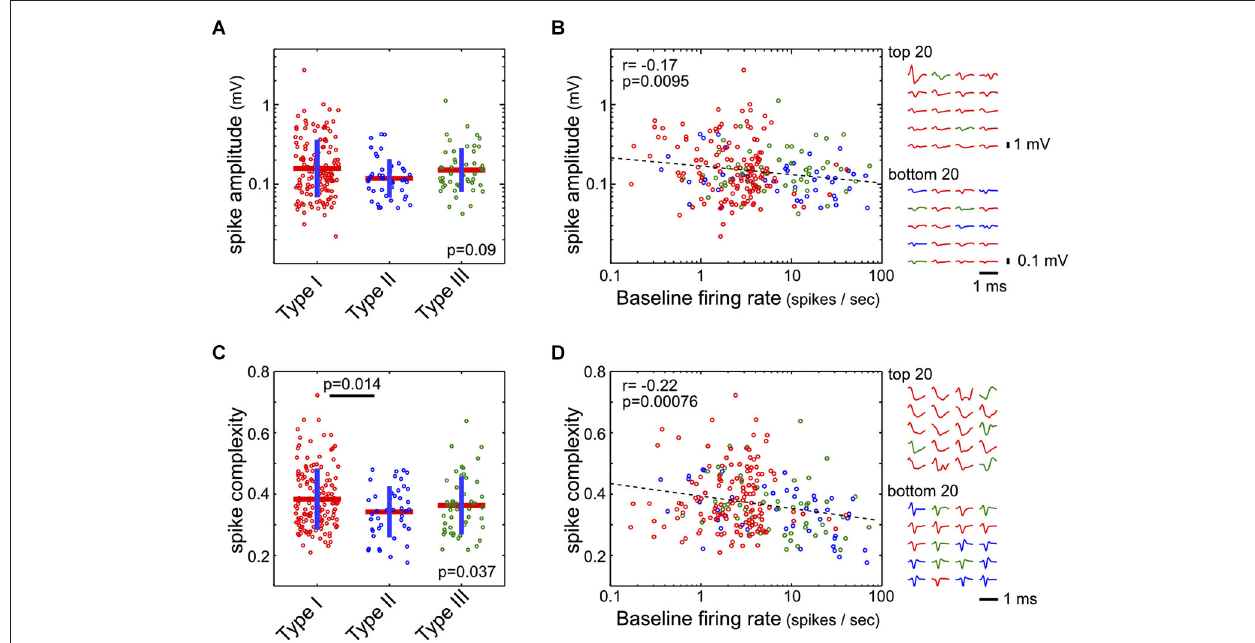
complexity, defined as the mean absolute amplitude of the peak normalized waveform, was higher in Type-I than in Type-II neurons (ANOVA, F ( 2,232 ) = 3.36, p = 0.037; significant post hoc t -test indicated). (D) Spike complexity showed a stronger dependency with baseline firing rate (Pearson correlation, r = − 0.22). Normalized spike waveforms for the 20 BF neurons with the most and least complex spike waveforms are shown on the